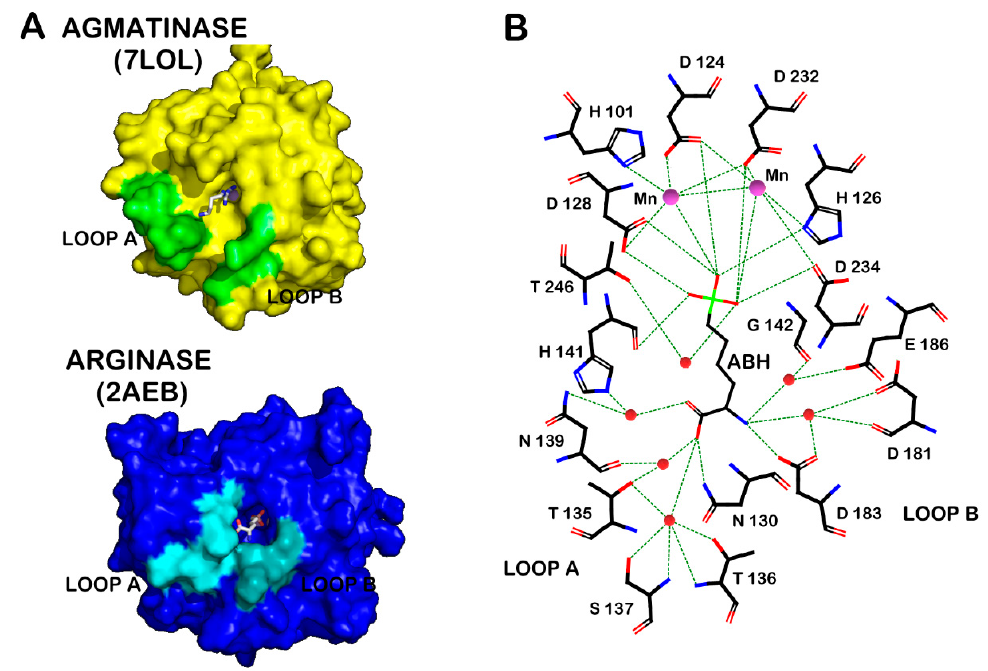
Figure 2. ( A ) Crystal structures of arginase in complex with substrate analogue 2(S)-amino-6- boronohexanoic acid (ABH) complex (PDB code 2AEB) and agmatinase-agmatine complex (PDB code 7LOL). Both complex are showing the loop A and loop B in different colors. ( B ) Residues involved in the interaction of ABH with arginase and Mn 2+ center (red spheres represent water mole- cules).